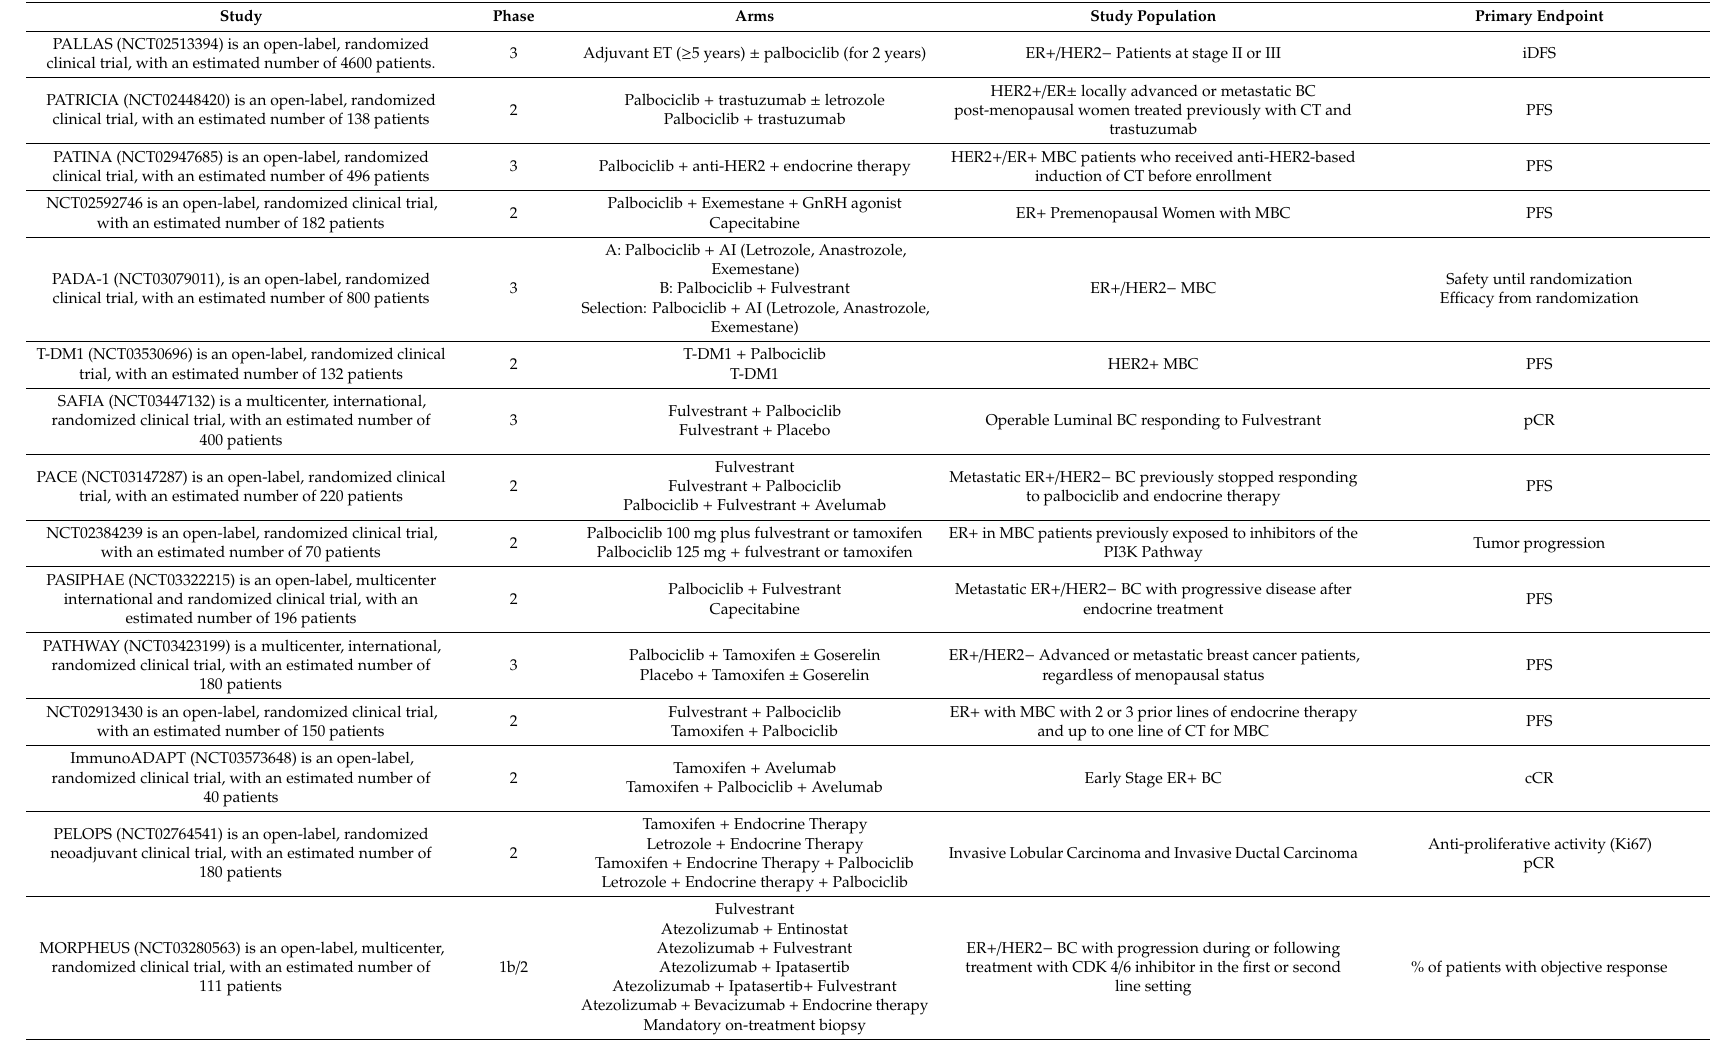
Table 3. Recruiting randomized phase II / III clinical trials investigating CDK4 / 6 inhibitors in breast cancer. Study Phase Study